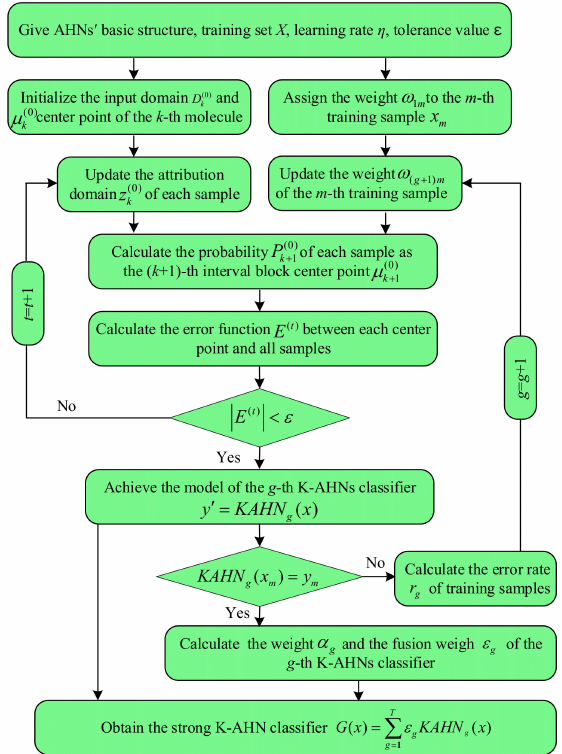
Figure 2. Flow chart of double-optimized